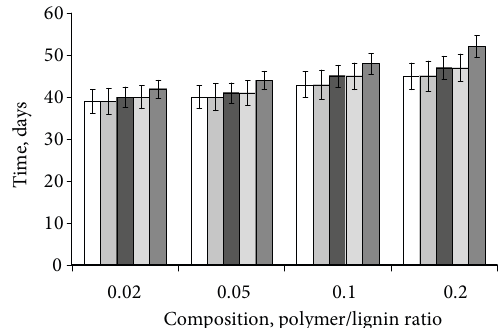
Fig. 5. Effect of moisture evaporation for sandy soil mulched with composite materials formed from , pine bark;